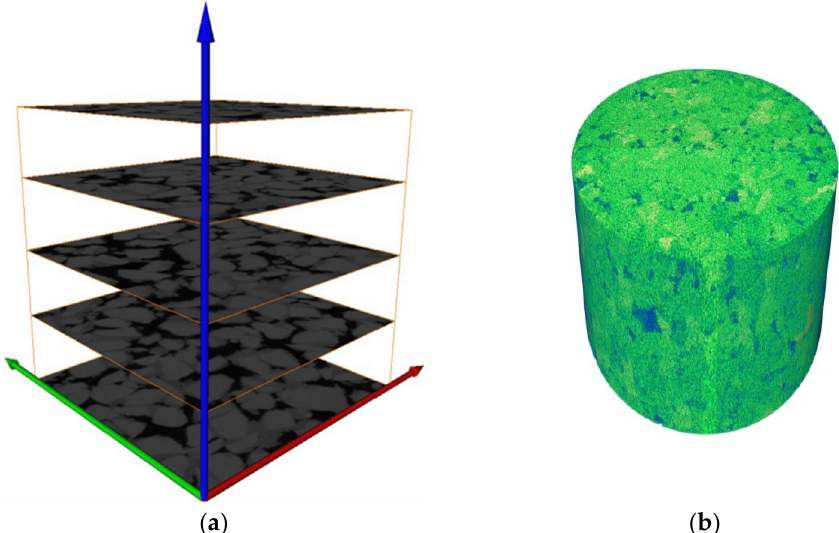
Figure 3. Schematic diagram of the principle of two-dimensional CT image superposition. ( a ) Slice scene graph. ( b ) 3D model diagram.